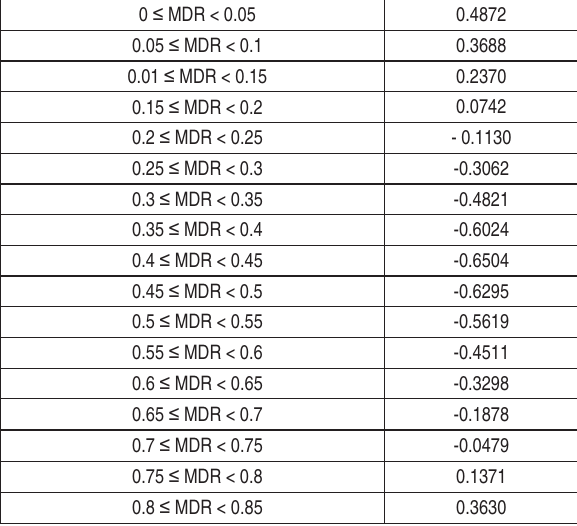
Table 2. NFE model for marginal effect